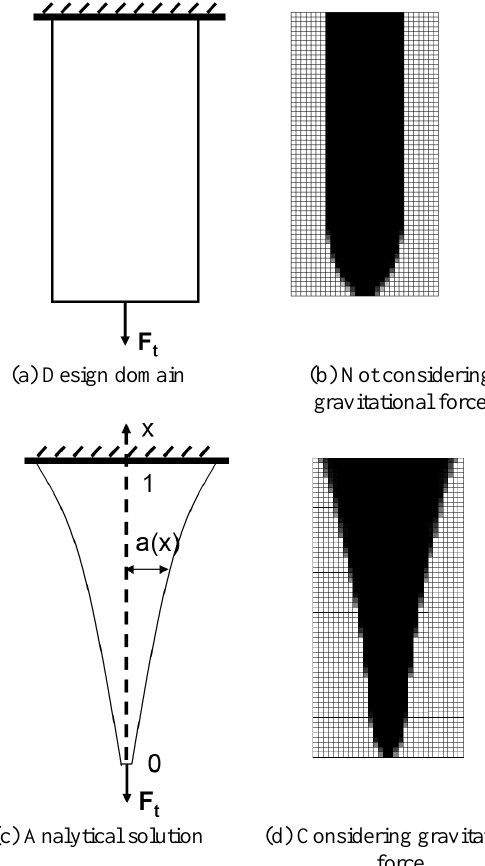
Fig.2. Optimization design for hanging structure considering gravitational